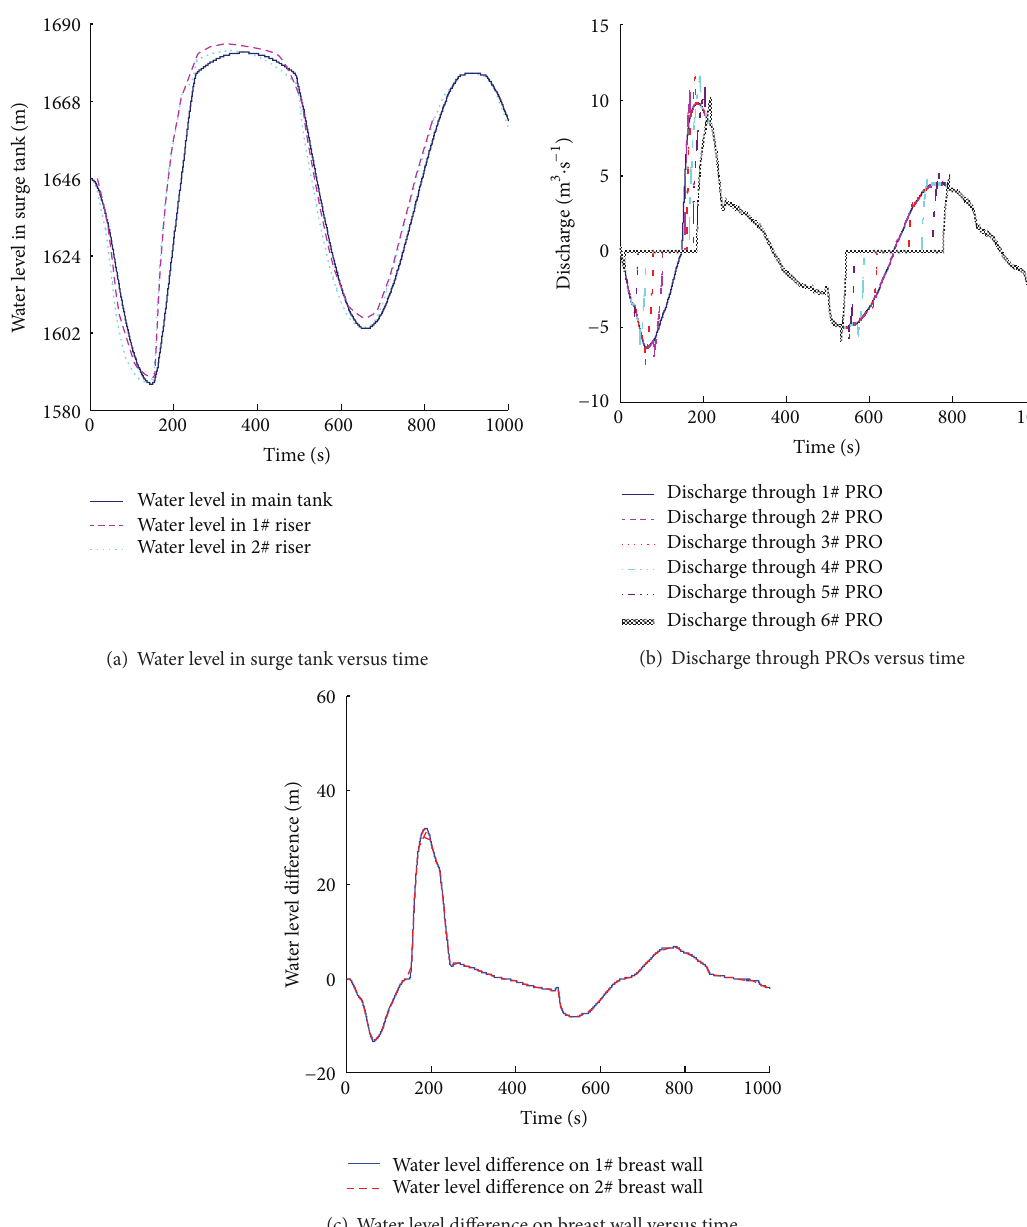
Figure 7: Numerical results of simultaneous load rejection after load acceptance with PROs on breast